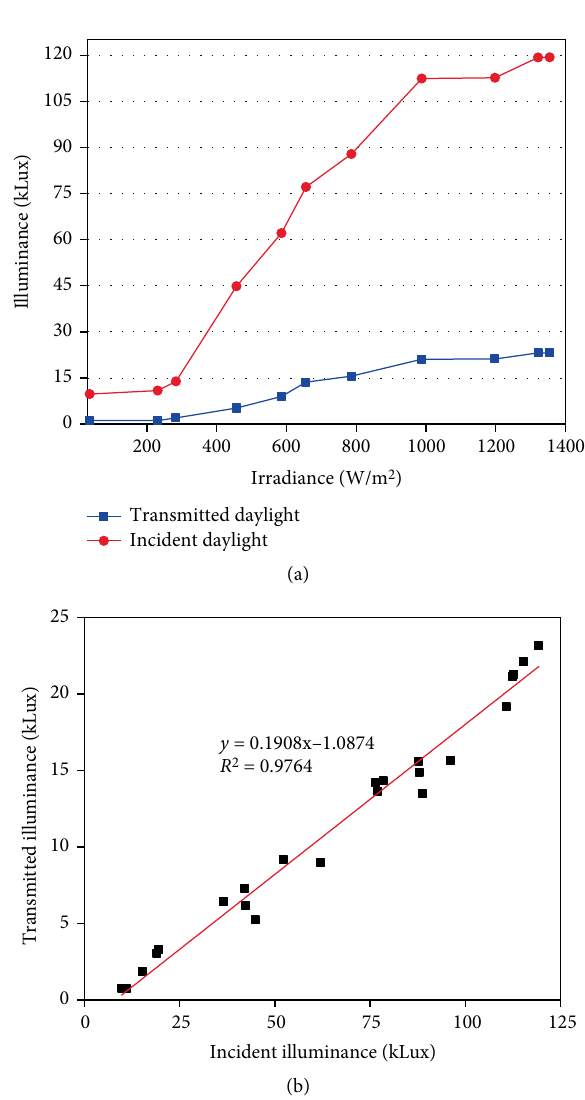
Figure 9: Variation of illuminance transmitted inside the room ( 𝐸 tr ) and incident ( 𝐸 in ): (a) 𝐸 tr and 𝐸 in vs. 𝐺 and (b) relationship between the 𝐸 tr and 𝐸 in